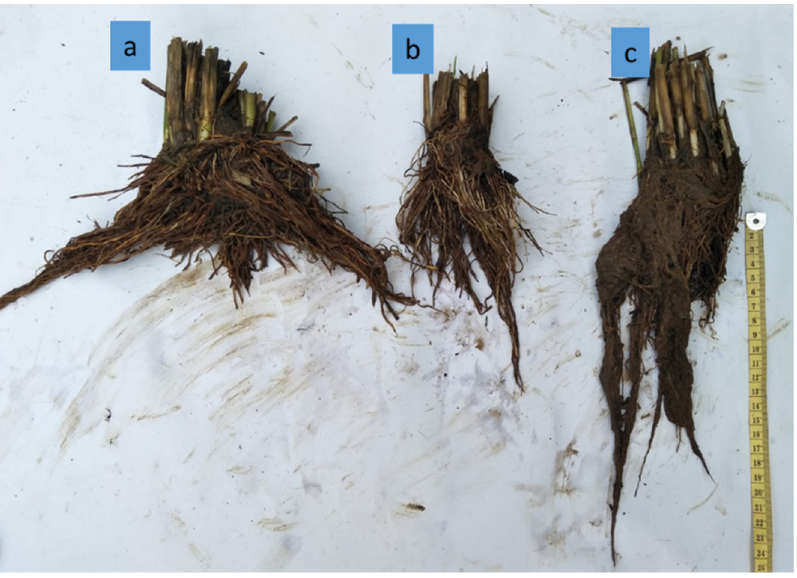
Figure 11. Root development of randomized hill of paddy in each regime: ( a ) CFI; ( b ) MFI; ( c )